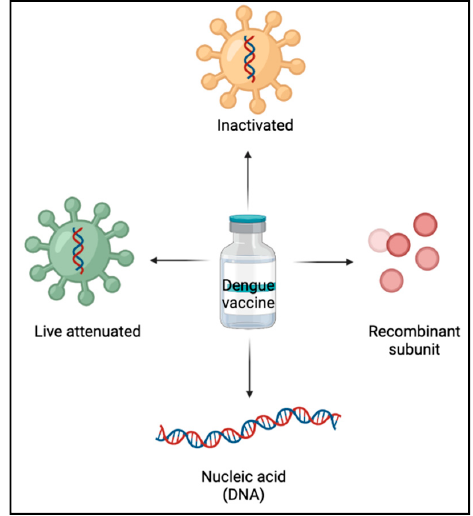
Figure 3. Types of dengue vaccines .